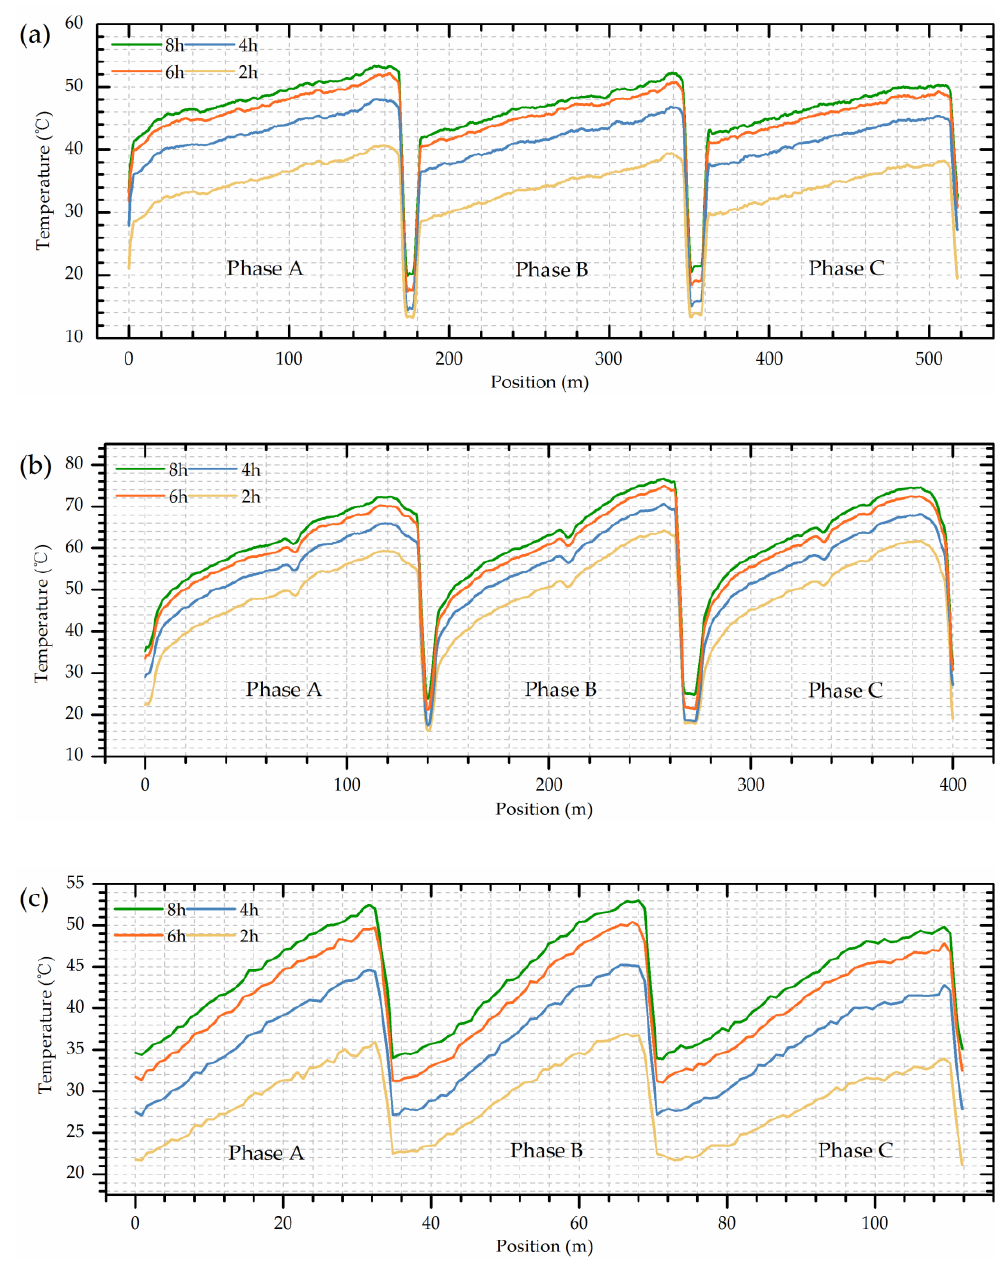
Figure 9. Spatial temperature at 2 h, 4 h, 6 h, and 8 h of ( a ) HV winding; ( b ) LV winding; ( c ) Iron core.